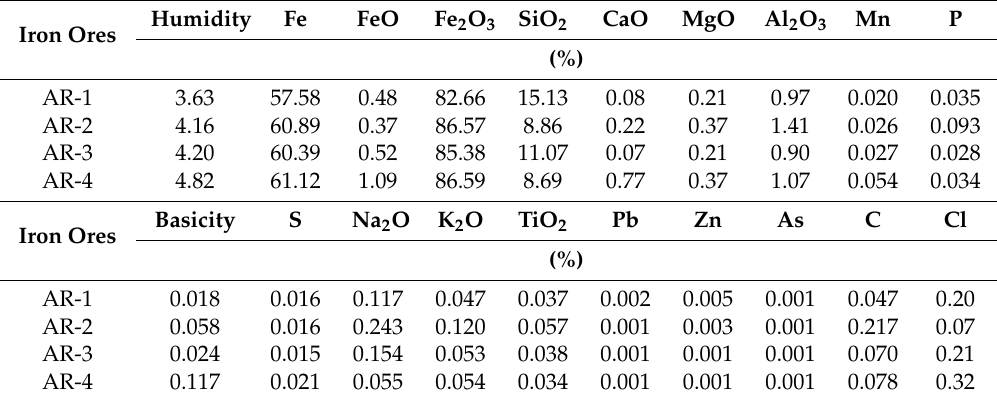
Table 1. The Chemical composition of iron ores used for experiment.